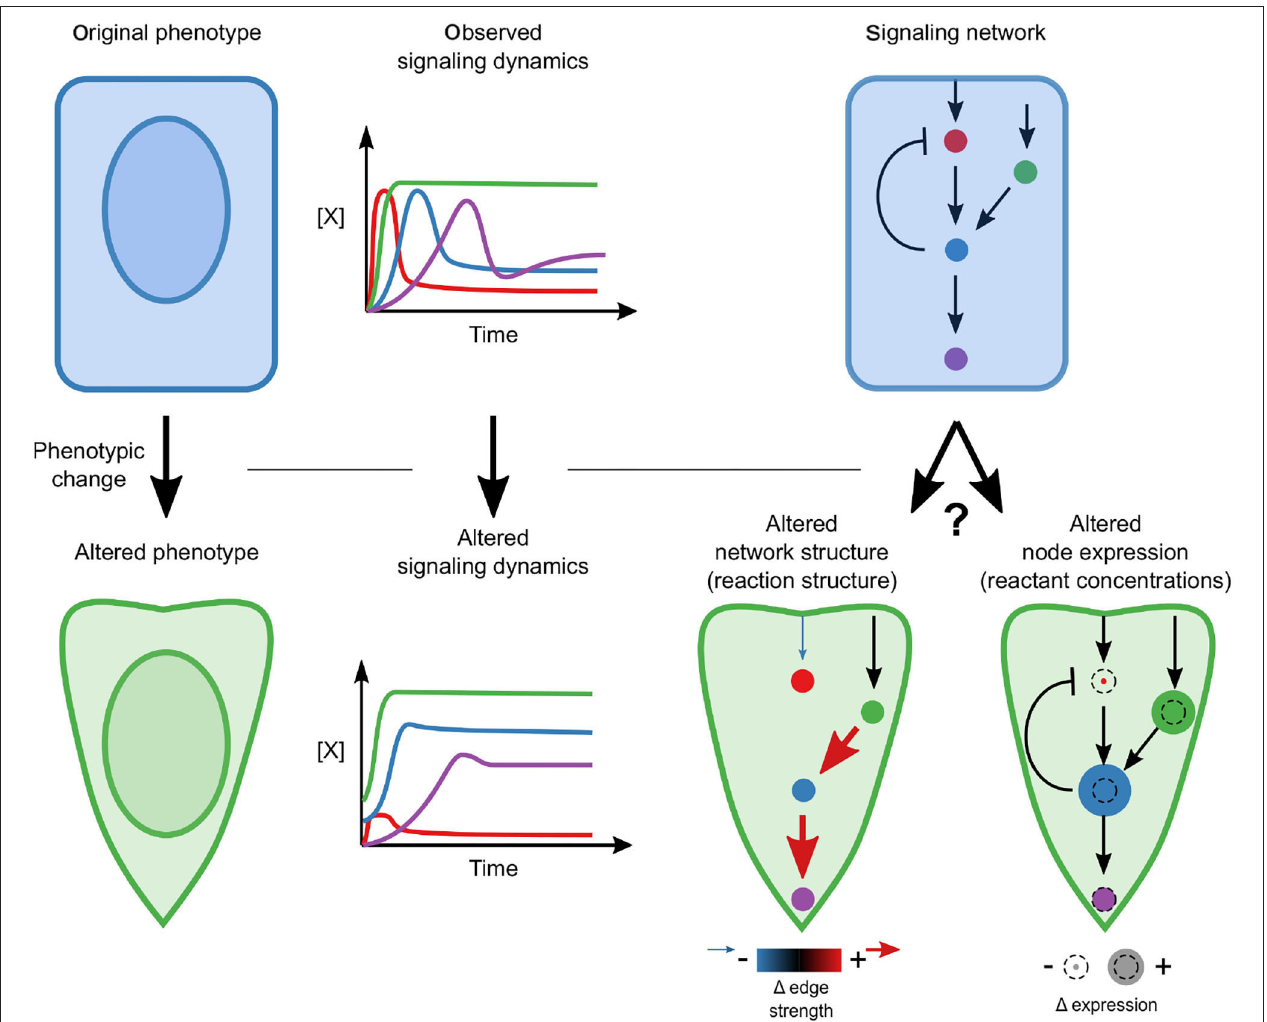
FIGURE 1 | Conceptual overview. A phenotypic transition is associated with a changed signaling response. A key question is whether this alteration requires network rewiring (associated with the addition or elimination of edges) or whether the network structure is constant and moderate differences in relative concentrations drive